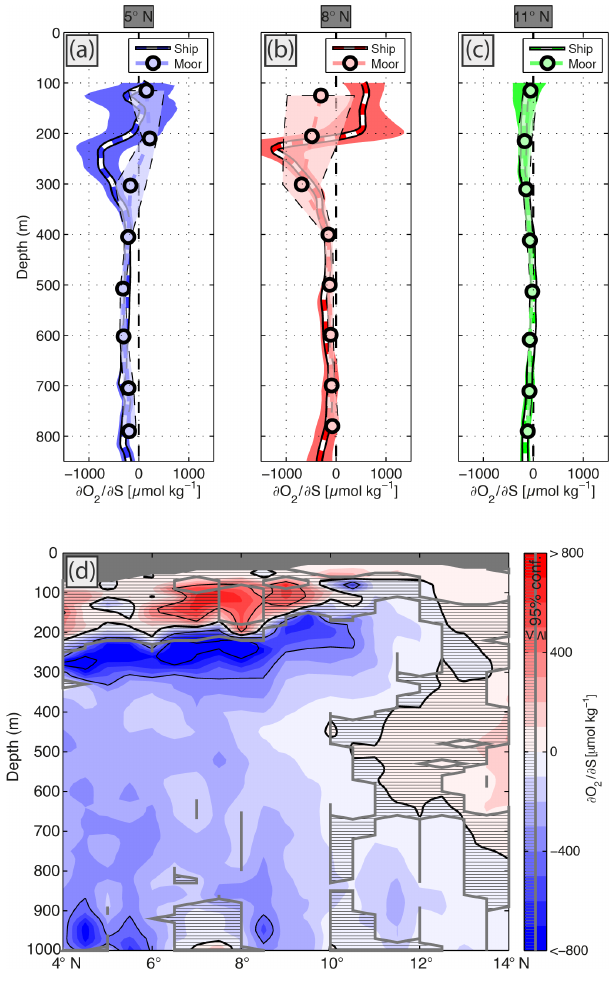
Figure 7. Vertical profiles of the slopes of the linear fits of oxygen against salinity with 95% confidence intervals for moored (white- colored dashed line) and shipboard observations (colored dots) at positions (a) 5 ◦ N, 23 ◦ W, (b) 8 ◦ N, 23 ◦ W and (c) 11 ◦ N, 21 ◦ W. (d) Depth–latitude section (along 23 ◦ W) of the slope of the linear fit of oxygen against salinity (filled contours). Gray-hatched areas define non-significant regimes with respect to 95%